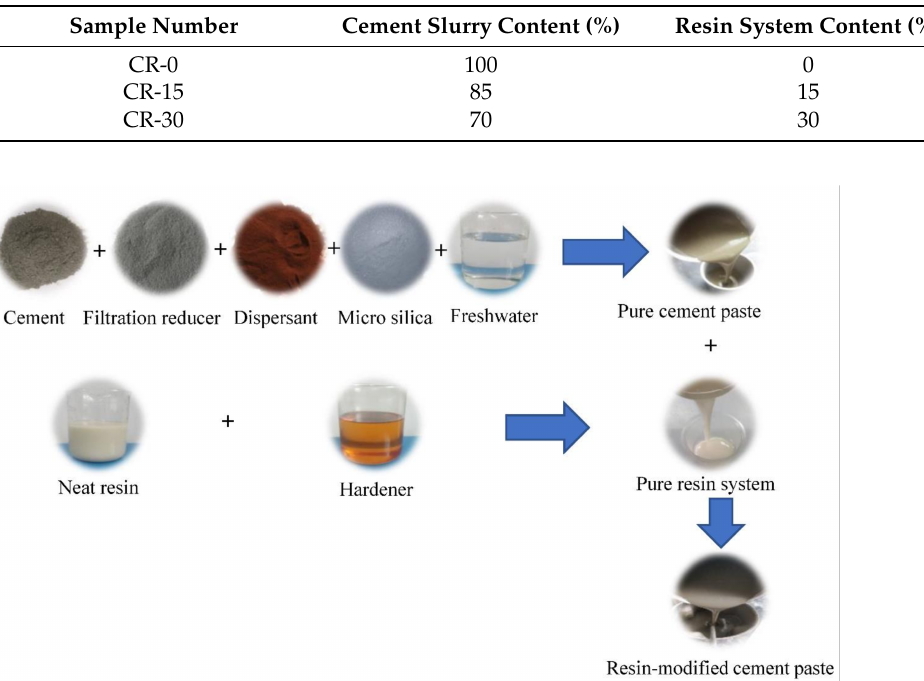
Figure 1. Sample preparation